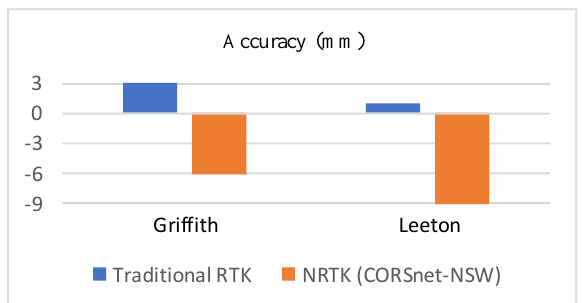
Figure 7 : Accuracy in relation to true